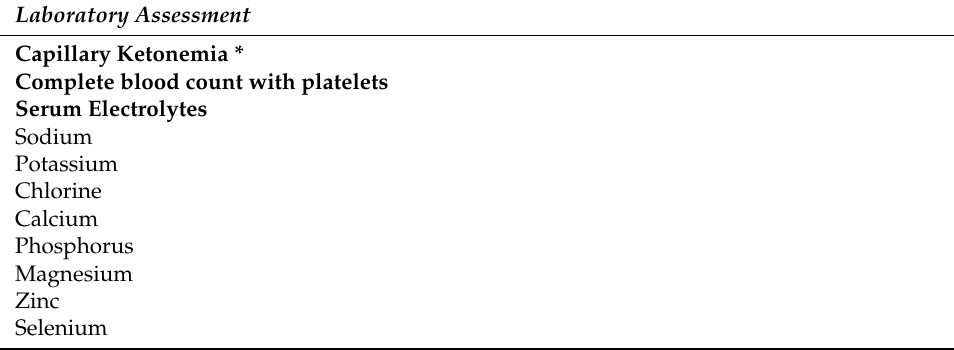
Table 2. Laboratory assessment currently in use in our center for patients under